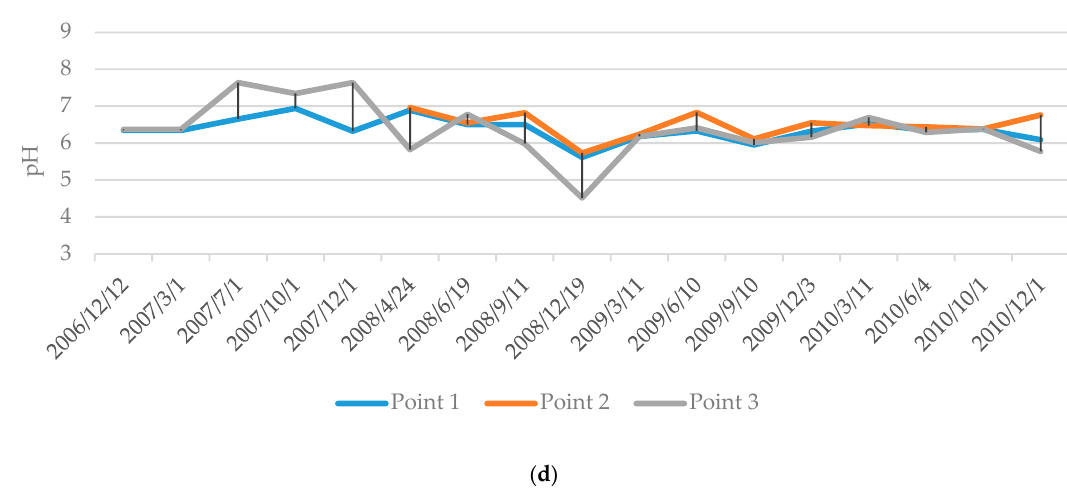
Figure 4. pH values measured during the survey period at ( a ) Lerez (San Xusto plant), ( b ) Umia (Hermida plant), ( c ) Ulla (Touro plant) and ( d ) Mandeo (Gomil plant).